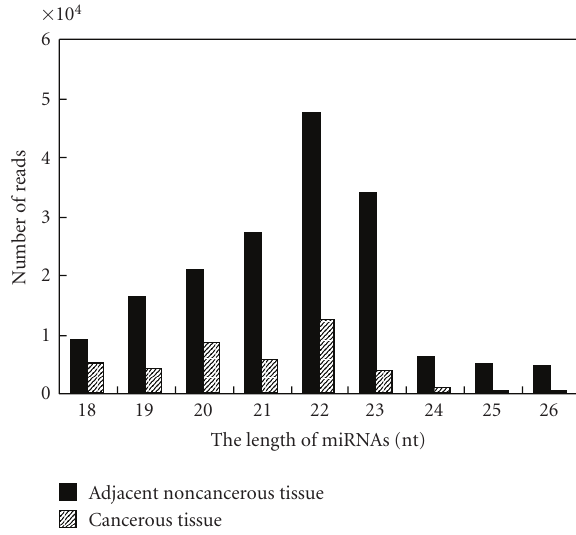
Figure 1: Length distribution of sequenced miRNAs. Table 1: Upregulated miRNAs (change > 2 fold as a cuto ff level) in cancerous tissue compared with noncancerous breast